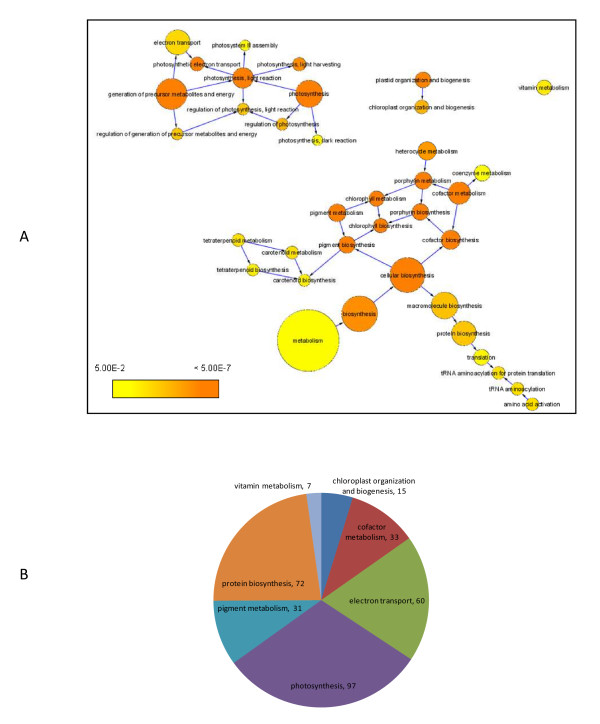
Functional analysis of module 1. (A) Significantly over-represented biological process GO terms detected in module 1. Each colored circle represents an over-represented GO term. The color scale indicates the p value of the over-represented GO term. An arrow from GO term A to Go term B indicates that A is the parent of B. (B). Seven major biological process GO terms retrieved from (A). The number following each major GO term refers to the number of genes that were annotated to that category. See our web site for the gene lists.